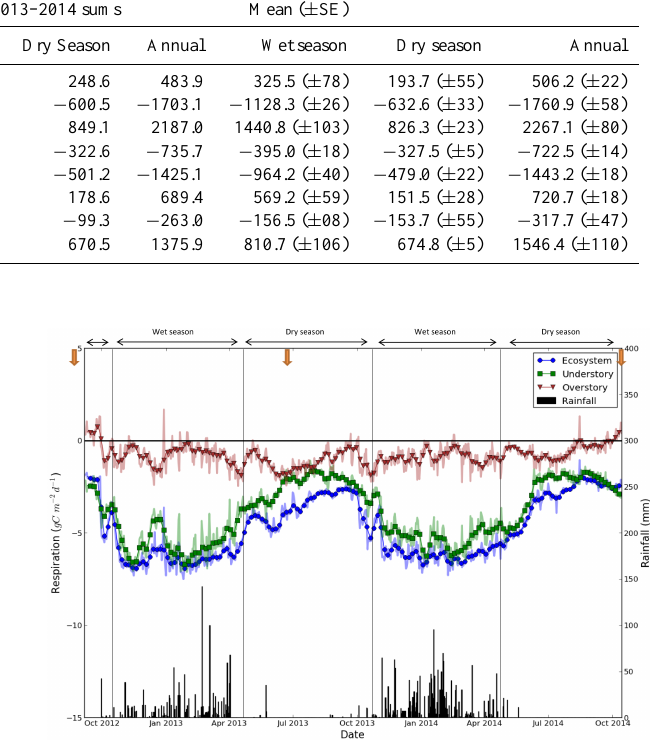
Figure 3. Net Ecosystem Productivity (NEP) for savanna ecosystem (23m tower) and understory (5m tower) components at the Howard Springs OzFlux site, Northern Territory, Australia from September 2012 to October 2014. Data shown are daily NEP totals with a 10- day running mean to aid visualisation. Orange arrows represent the timing of fire events (for fire intensity see Table 2). Positive fluxes indicate a net sink of carbon to the savanna whereas negative fluxes are a net source of carbon to the atmosphere. Rainfall is also in- cluded as daily totals.